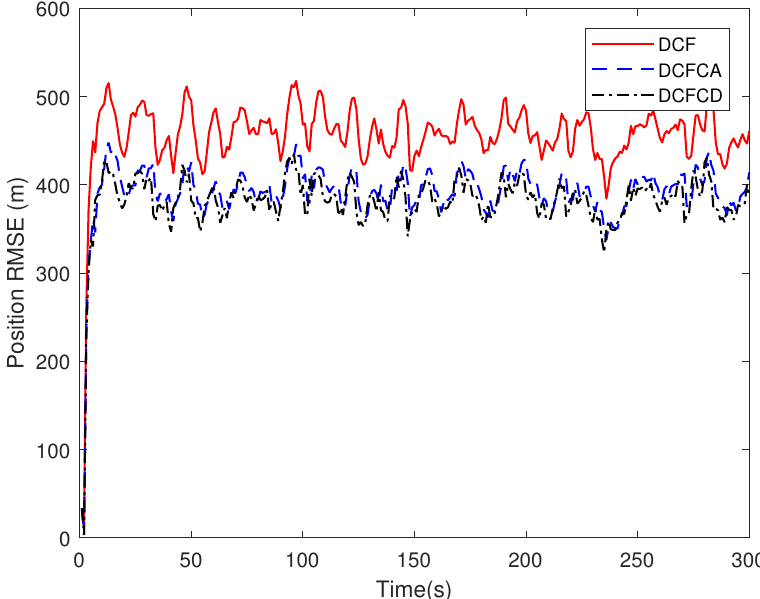
Figure 7. The position RMSE for different local filters of failure node without consensus.